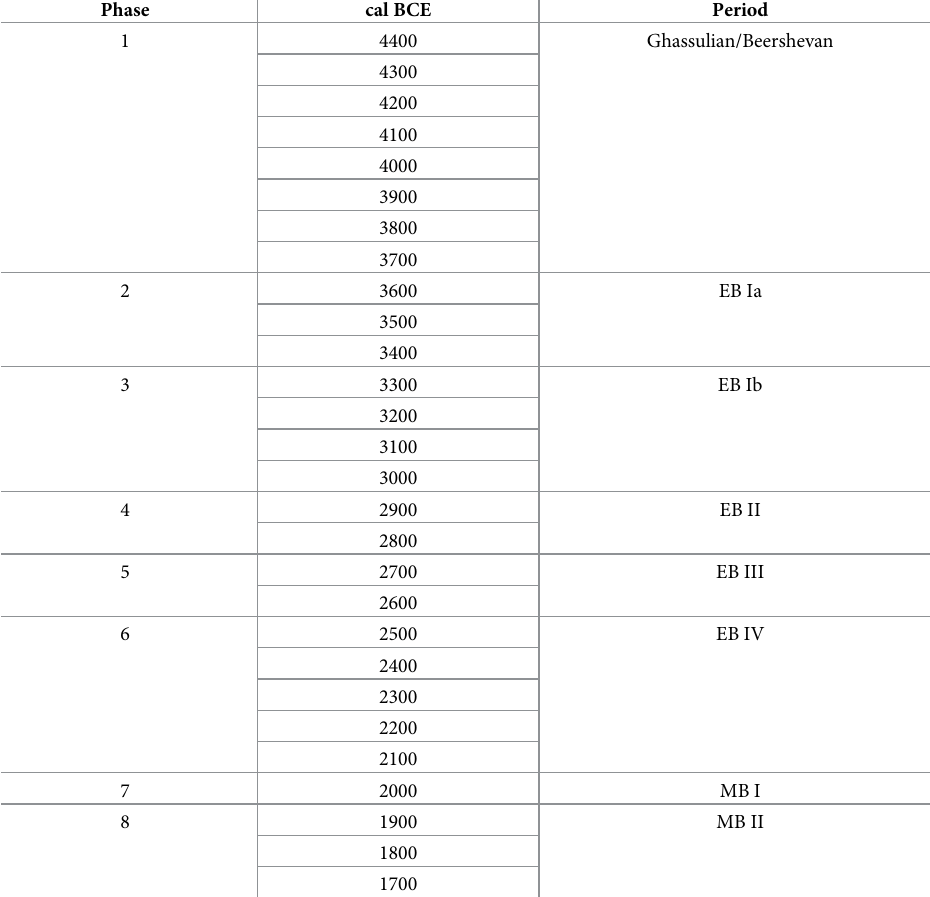
Table 1. Chronological periods used in this study. Based on: [58]; [110] and [111]. Phase cal